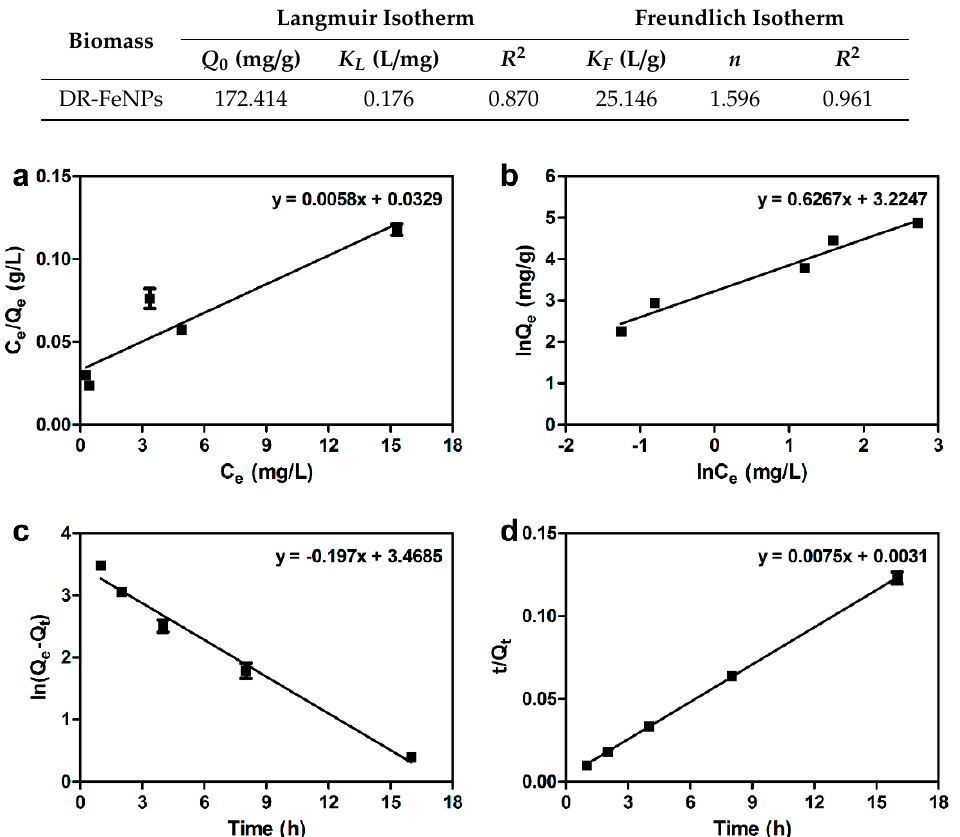
Figure 4. Optimization of adsorption conditions for maximum removal efficiency according to ( a ) pH, Table 1. Langmuir and Freundlich model parameters. DR-FeNPs, magnetic iron nanoparticle-immobilized ( b ) contact time, ( c ) the amount of biomass, and ( d ) initial concentration of As(V). Experimental D. radiodurans R1 strain. conditions were as follows: ( a ) contact time = 24 h, biomass = 0.2 g/L, initial concentration of As(V) = 50 mg/L; ( b ) initial pH = 3, biomass = 0.25 g/L, initial concentration of As(V) = 50 mg/L; ( c ) initial pH = 3, contact time = 16 h, initial concentration of As(V) = 50 mg/L; ( d ) initial pH = 3, contact time = 16 h, biomass = 2.5 g/L. All experiments were performed in triplicate; error bars denote standard deviation.